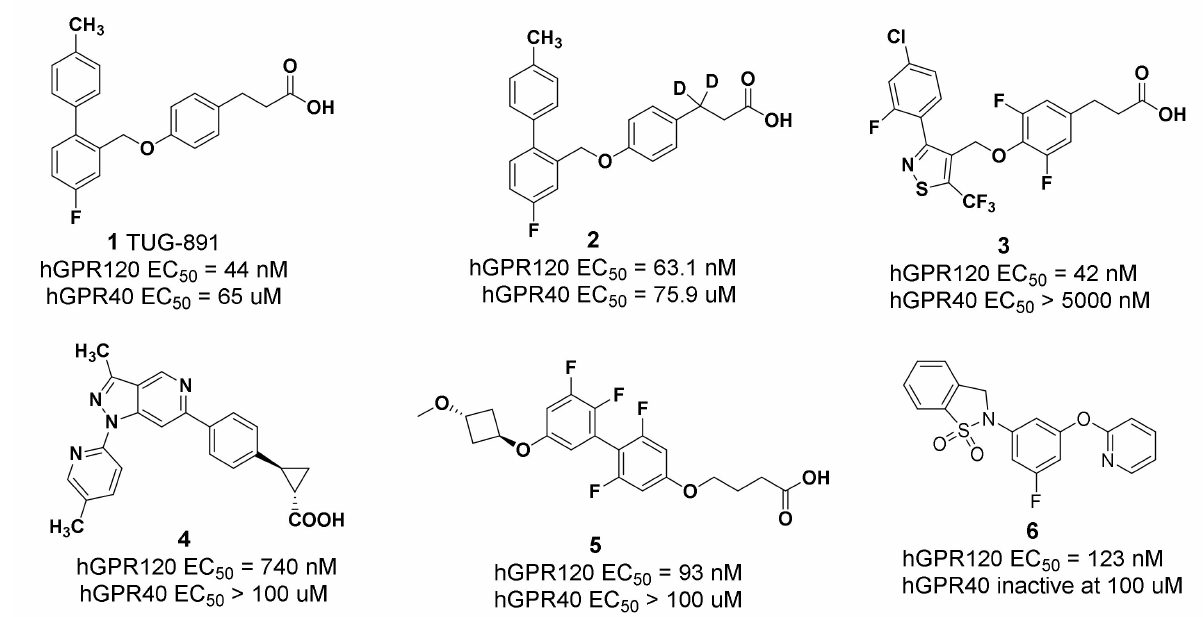
Figure 1. Representative GPR120